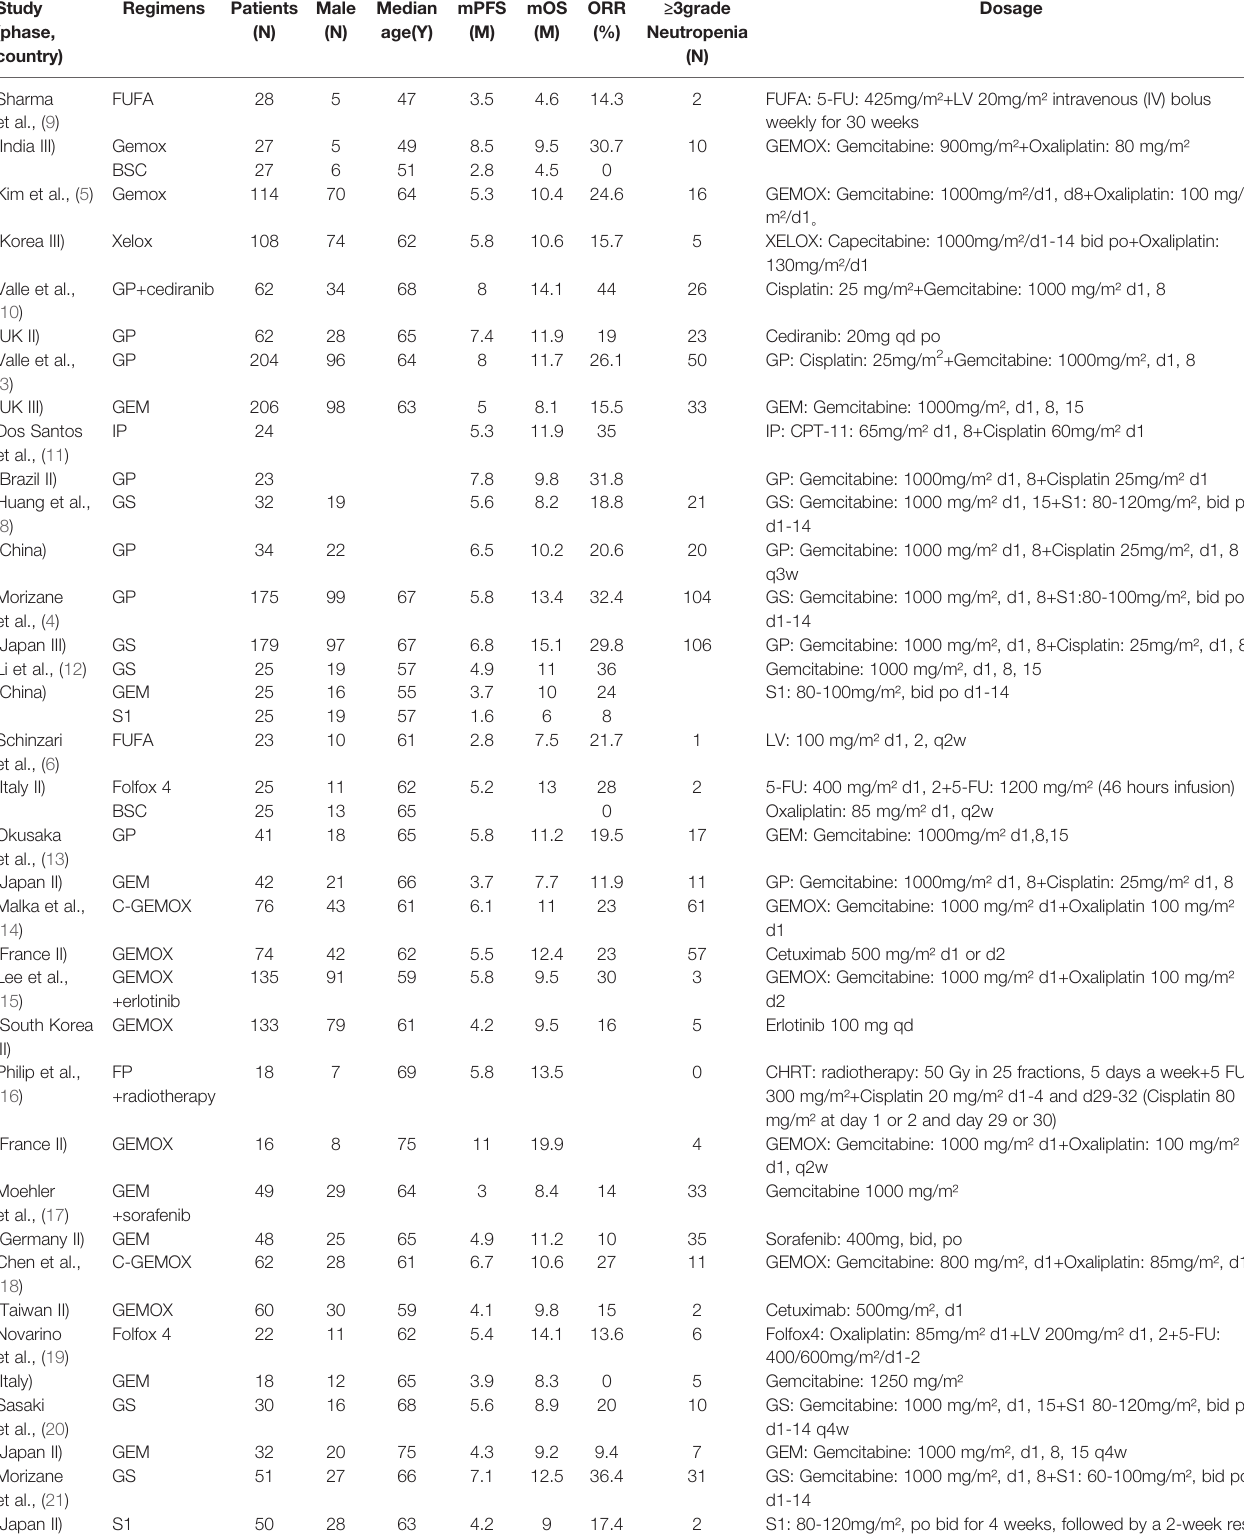
TABLE 1 | Characteristic and treatment characteristic of the included studies. Study (phase, country) Sharma et al.,